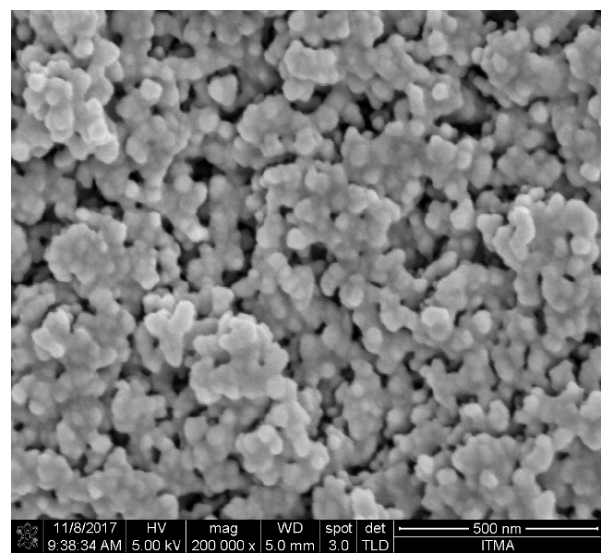
Figure 5. Field emission scanning electron microscopy (FESEM) image of TiO 2 -B 2 O 3 on the alumina substrate at T = 500 °C.